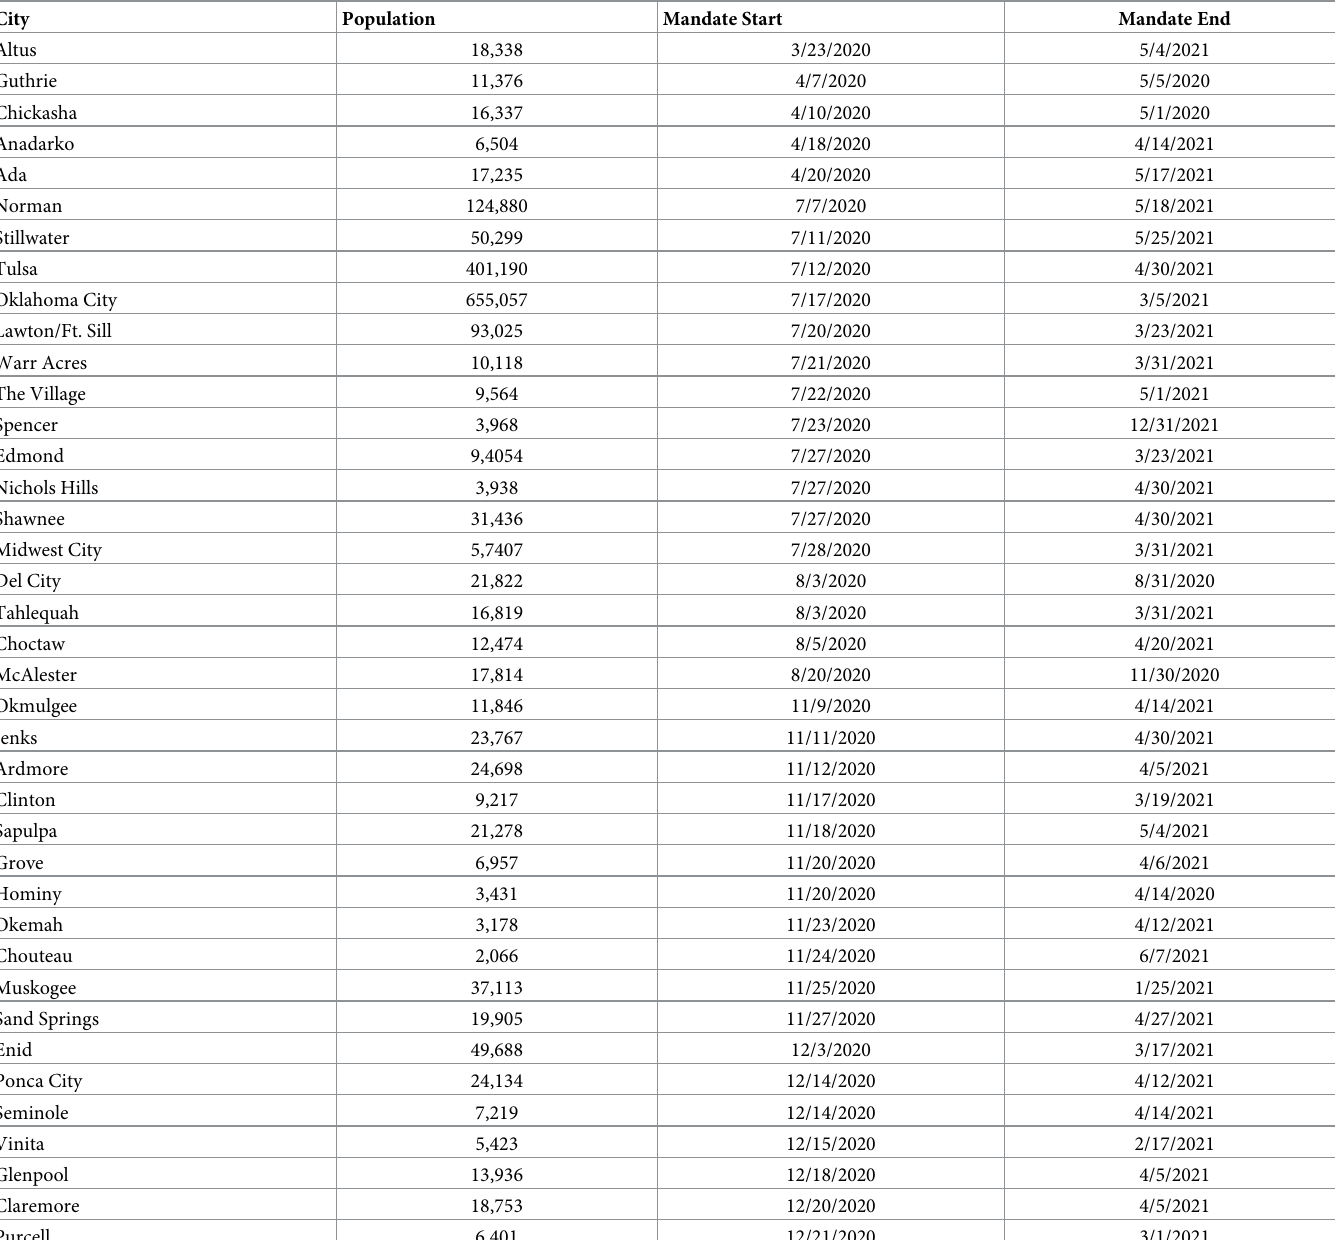
Table 1. Oklahoma municipalities that adopted mask mandates, along with the population, mandate start and expiration